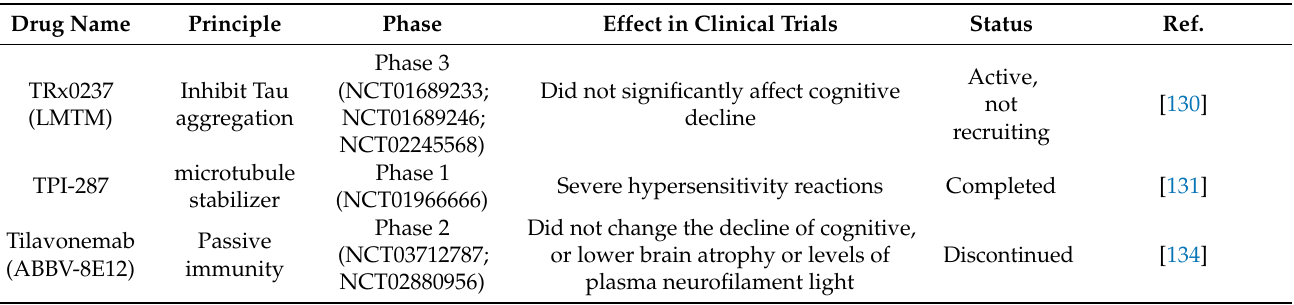
Table 4. Alzheimer drugs targeting tau